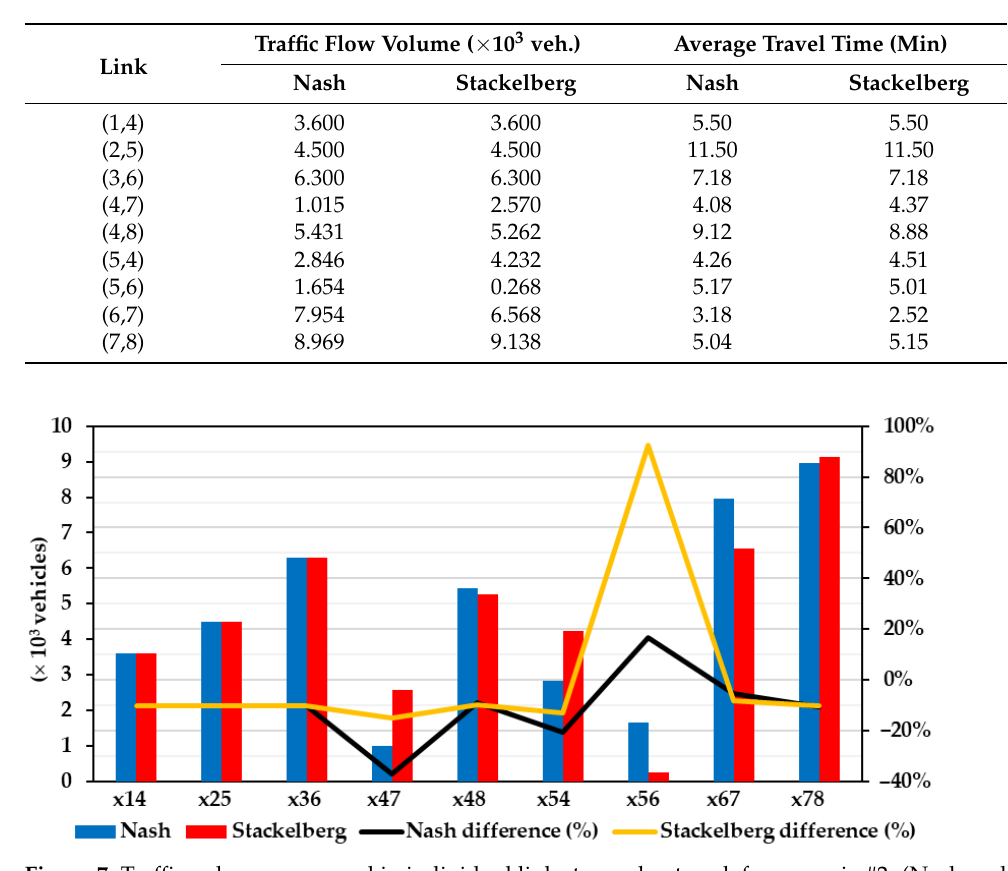
Figure 8. This is a figure. Schemes follow the same formatting. If there are multiple panels, they should be listed as: ( a ) Description of what is contained in the first panel. ( b ) Description of what is contained in the second panel. Figures should be placed in the main text near to the first time they are cited. A caption on a single line should be centered.